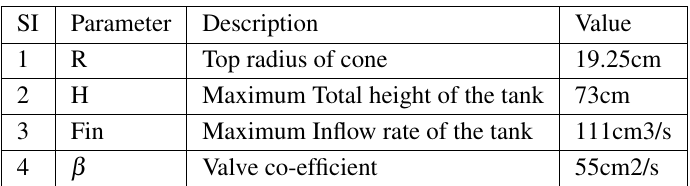
Table 1. Operating